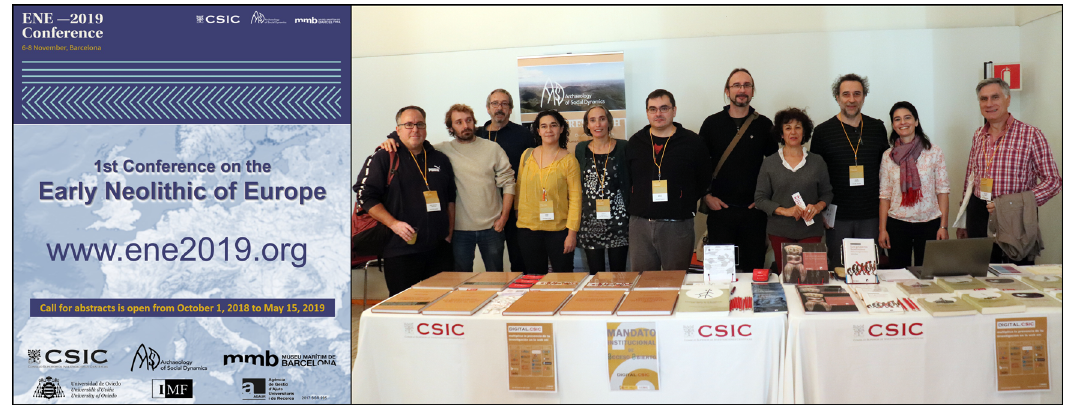
Figure 1: Organising Committee of the 1st Conference on the Early Neolithic of Europe at the Editorial CSIC 2 stand during the